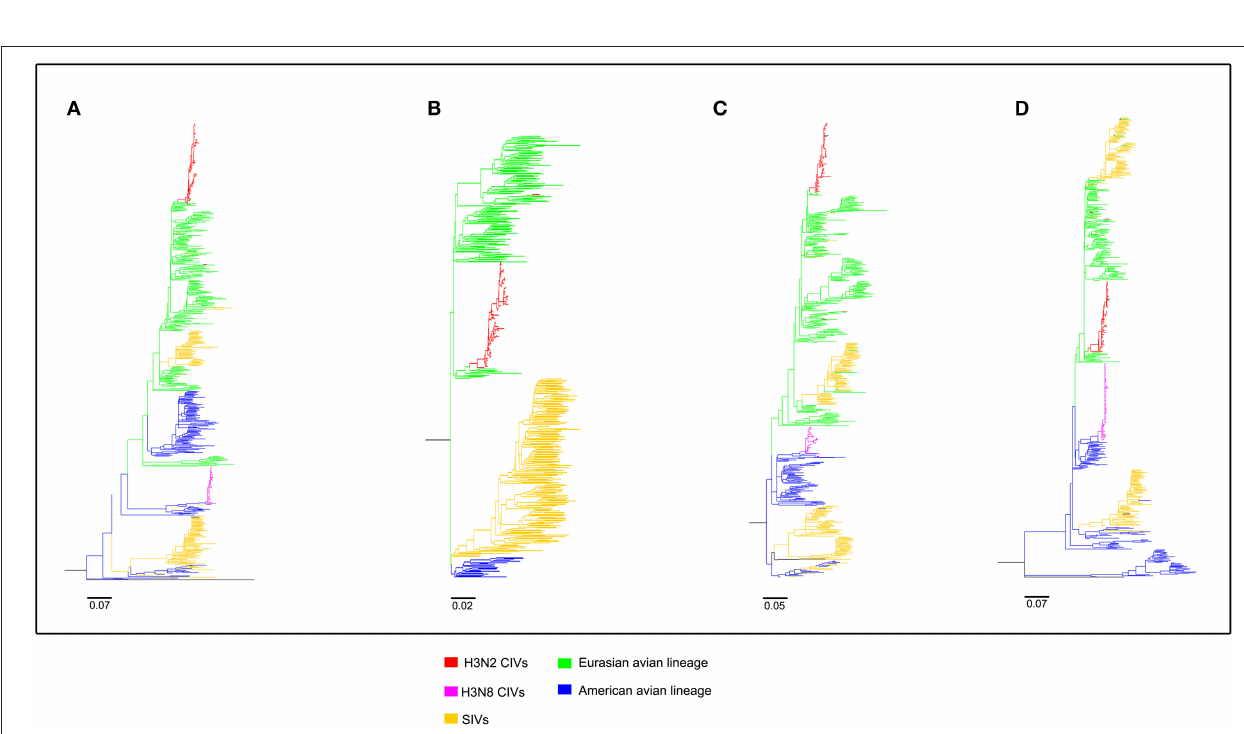
FIGURE 3 | Maximum likelihood trees of segment 5-8 of H3N2 CIVs. (A) NP; (B) NA; (C) M; (D) NS. Colored branches represent distinct lineages. H3N2 CIVs: red, H3N8 CIVs : purple, SIVs: yellow, Eurasian avian lineage: green, and American avian lineage: blue. The bars are drawn to scale.